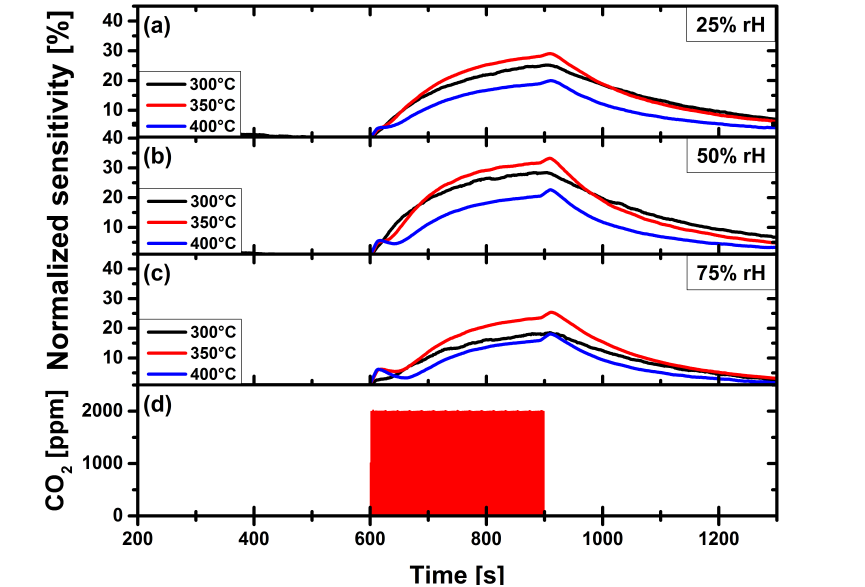
Figure 7. Carbon dioxide measurement of pristine CuO gas sensor, at operation temperatures 300 ◦ C, 350 ◦ C and 400 ◦ C, at constant relative humidity levels of: ( a ) 25%. ( b ) 50%. ( c ) 75%. ( d ) Applied gas pulse of 2000 ppm CO 2